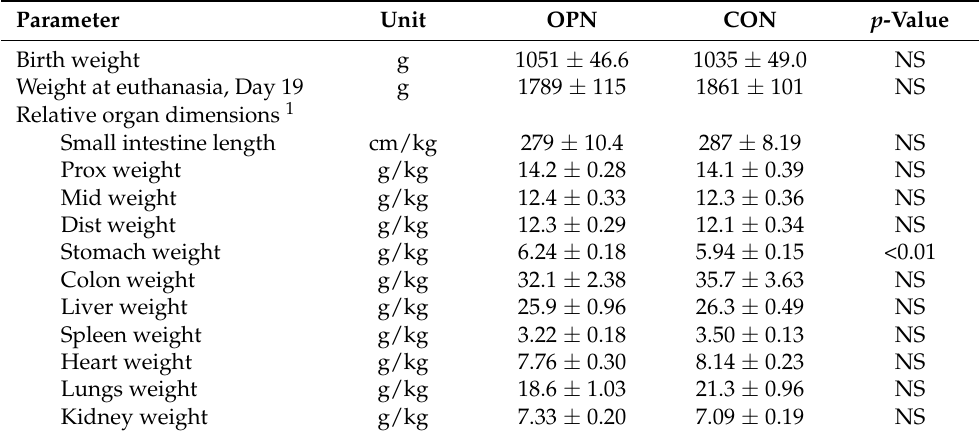
Figure 3. Growth curves based on daily body weights of the preterm pigs from Days 1–19. The pigs received either a bovine milk diet (CON, n = 19) or the milk diet supplemented with bovine milk osteopontin (OPN, n = 16). Data are expressed as mean ± SD. Table 1. Growth and organ dimensions of preterm pigs fed a bovine milk diet (CON, n = 19–21) or the milk diet supplemented with OPN (OPN, n = 16–21).